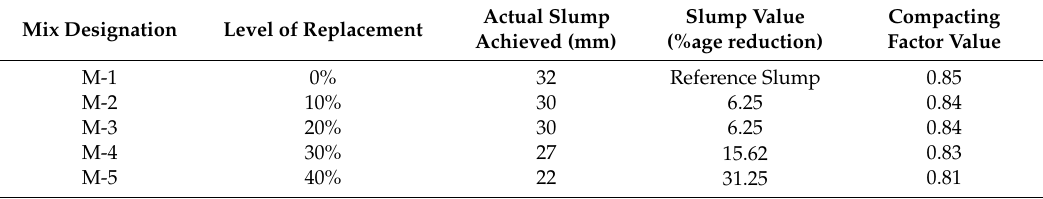
Table 5. Slump and compacting factor (CF) values at di ff erent substitution